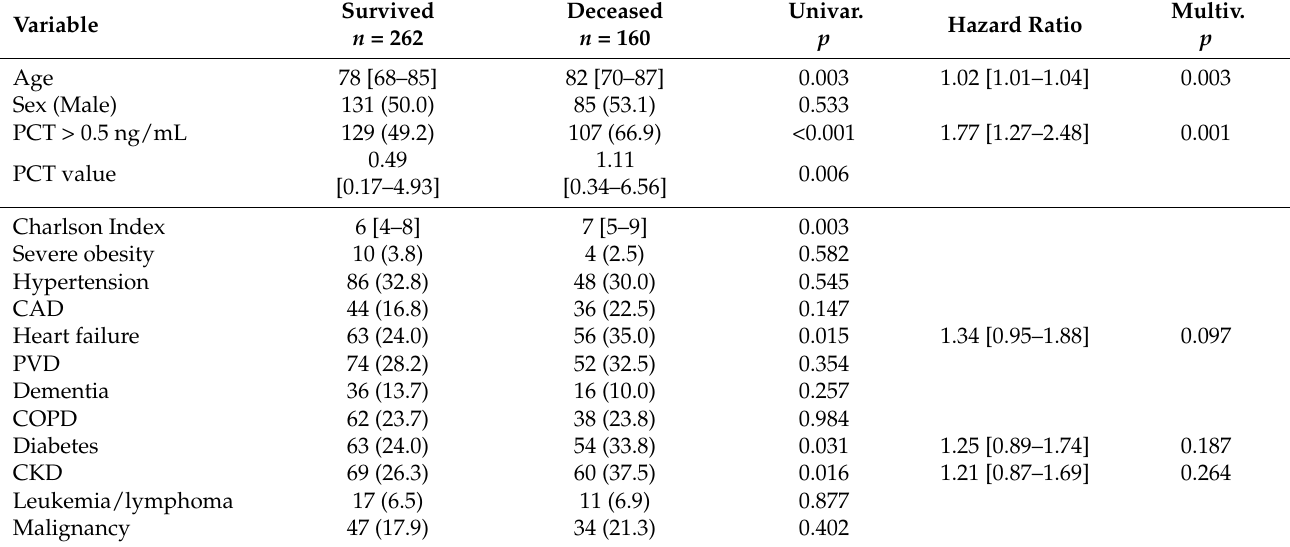
Table 3. Univariate and multivariate analysis for in-hospital death in patients with a septic presentation in the Emergency Department (Sep